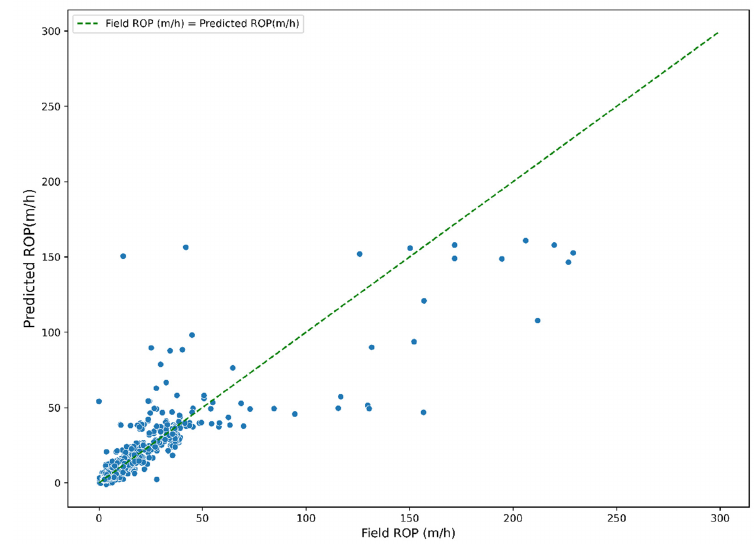
Figure 17. Measured vs predicted ROP by ANN .